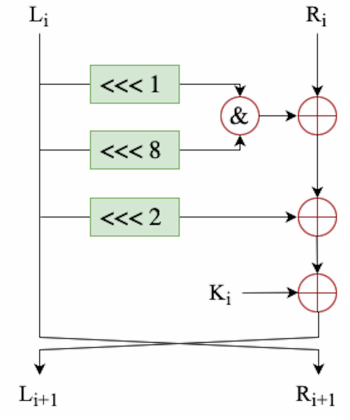
Figure A2. Simon round function. Table A1. Variants of Speck and Simon . The parameters α and β , as seen in Figure A1, count the number of positions for the right and left shifts, respectively. The values α = 7 and β = 2 are for Speck 32/64, while other variants of Speck use α = 8 and β =